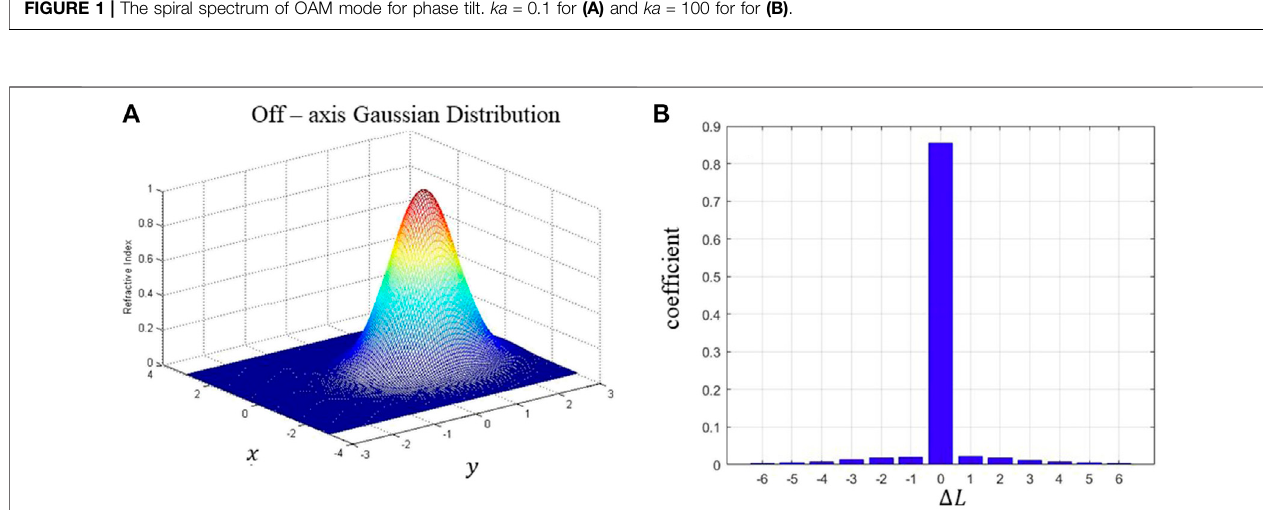
FIGURE2| Thespiralspectrum ofOAMmodeforthesingle Gaussiondistribution. (A) Thegivenphasedistributionwith ρ 0 (cid:2) 1. (B) Thespiralspectrum distribution calculated by Eq. 3 .